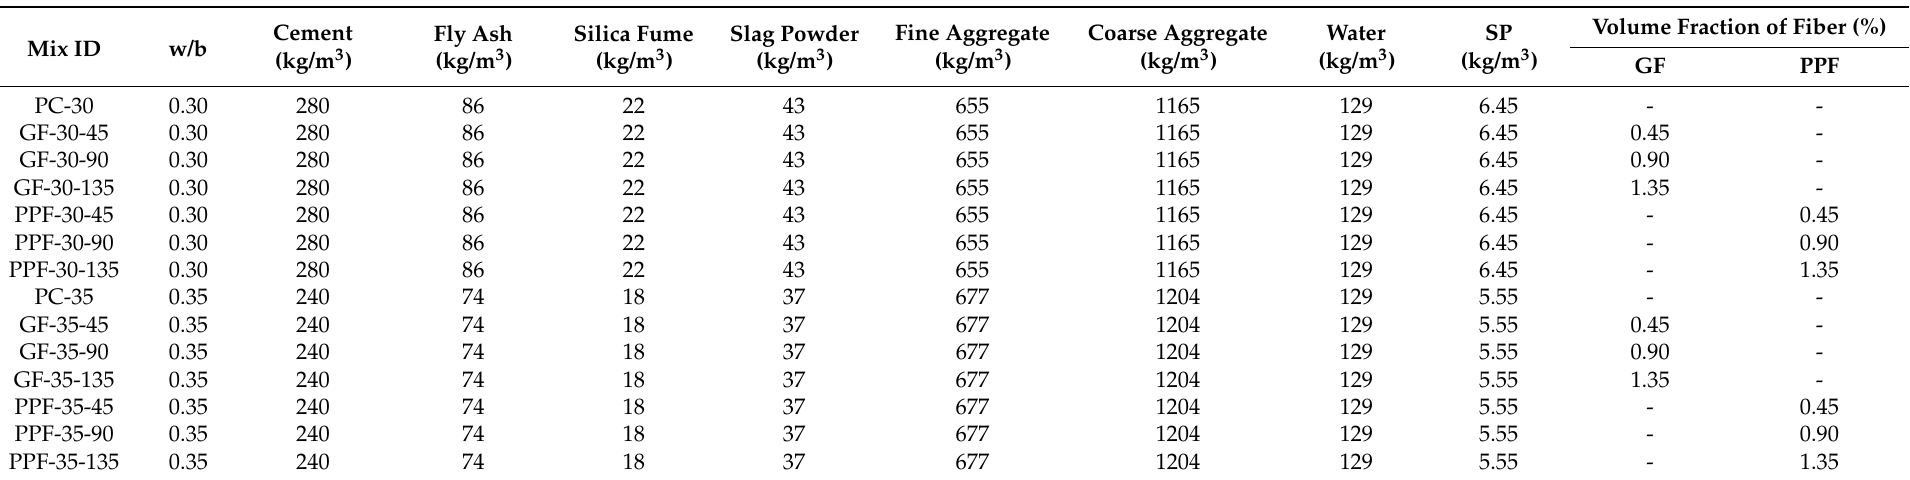
Table 7. The mixture proportions of the concrete